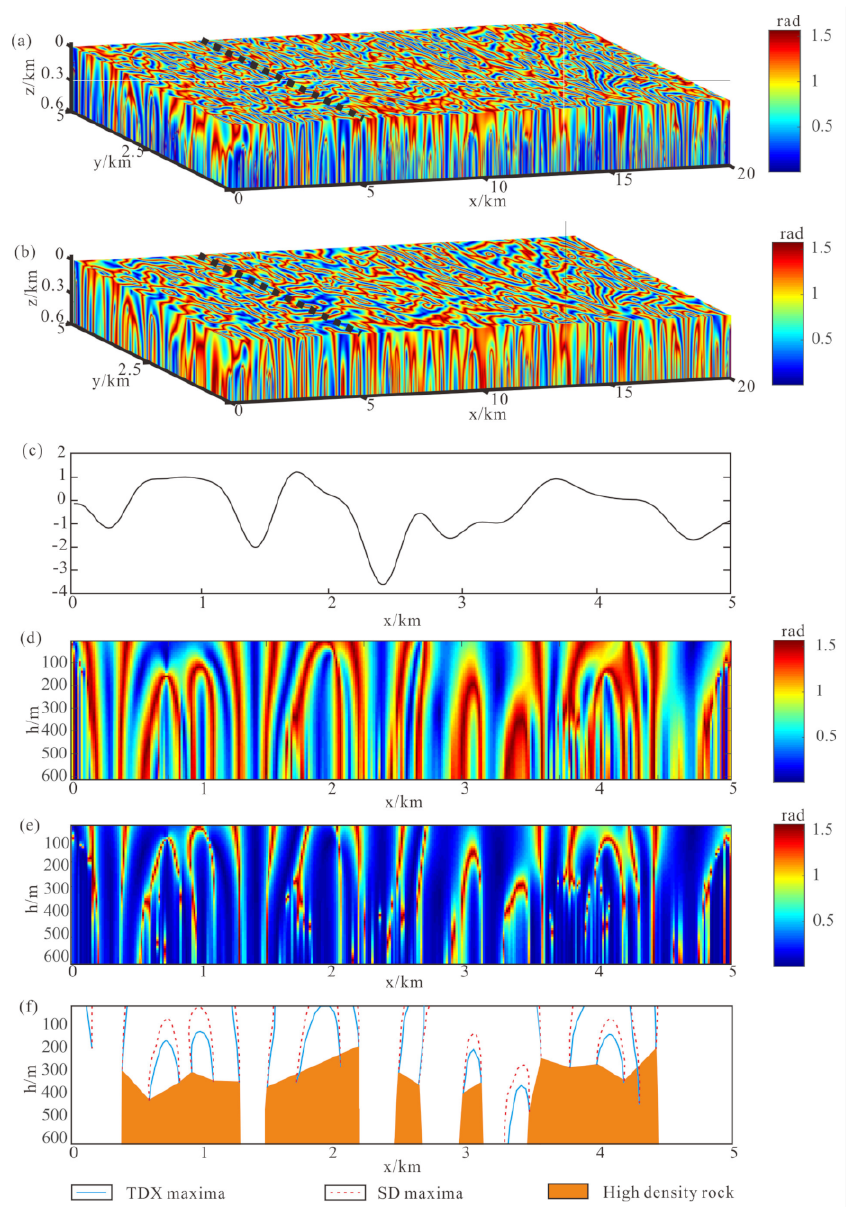
Figure 11. ( a ) 3D TDX results of the study area; ( b ) 3D SD results of the study area; ( c ) Gravity anomaly of x = 5 km profile; ( d ) TDX profile of x = 5 km profile; ( e ) SD profile of x = 5 km profile; ( f ) Inversion results of x = 5 km